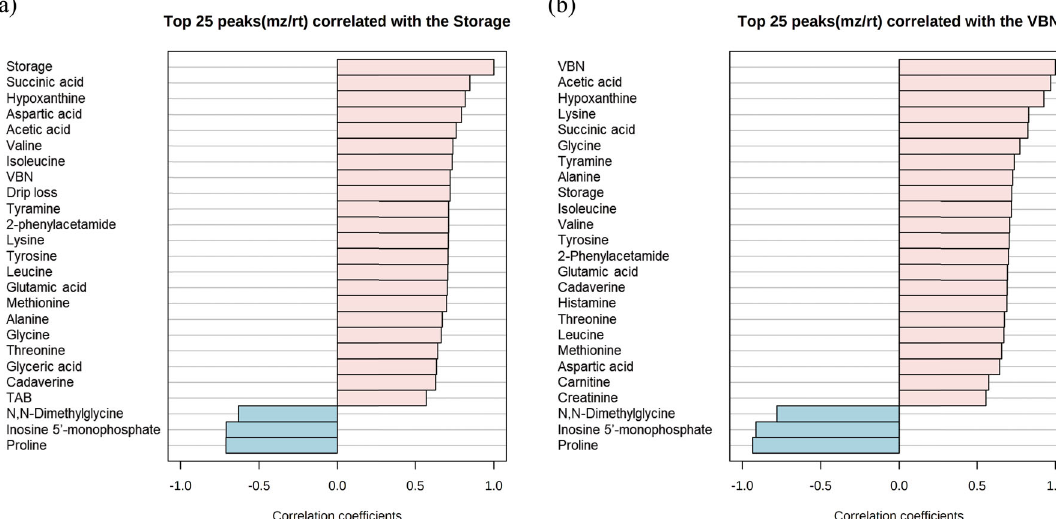
Fig. 2 Correlation of physicochemical properties and metabolites. Top 25 items correlated by storage day ( a ) and volatile basic nitrogen (VBN) (mg%) ( b